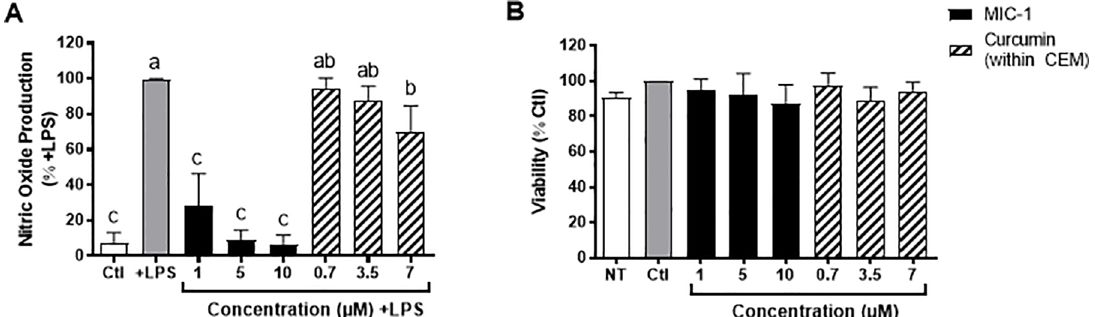
Fig 6. Effects of MIC-1 (1, 5, and 10 μ M) and CEM (curcumin concentrations of 0.7, 3.5 or 7 μ M) on LPS-stimulated NO production and viability of RAW 264.7 murine macrophages. A) NO production in MIC-1 and CEM-treated cells compared to Ctl without LPS and +LPS control. B) Viability of cells (MTT assay) treated with MIC-1 and CEM comparedto no-treatment (NT) and Ctl cells. Data are the mean ± SD of 3 independent experiments for NO assay and 5 independentexperiments for cell viability. Different letters indicatesignificantdifference, one-wayANOVA followedby Tukey’s post hoc test.